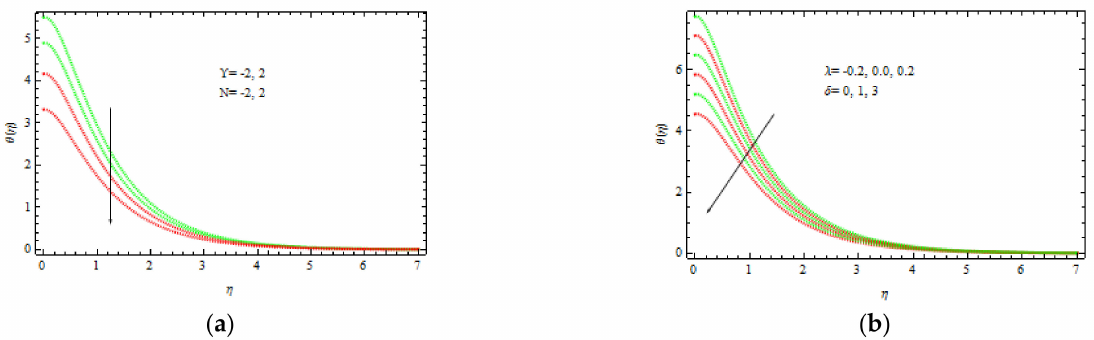
Figure 8. Inspiration of Y , N ( a ) and λ , δ ( b ) on